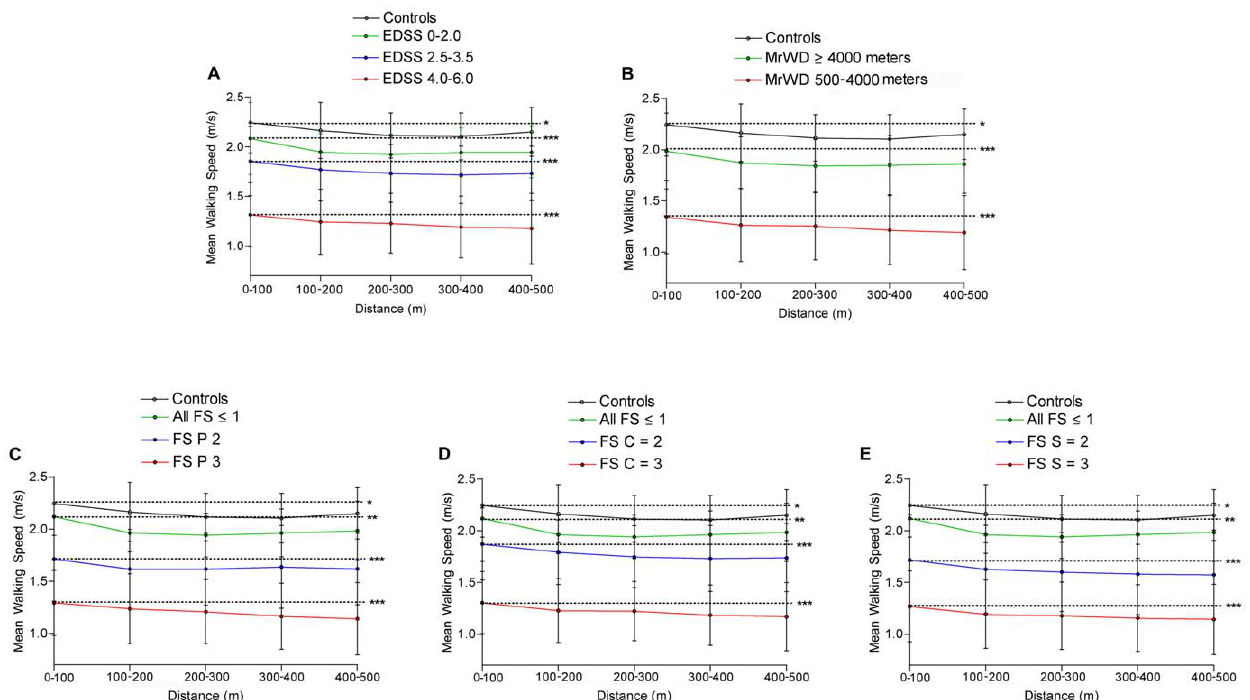
Figure 2. MWS over five successive 100 m interval laps along the T500MW. Subgroup analysis are presented in healthy volunteers and in different subgroups of the pMS population, stratified according to their EDSS (A), their maximum reported walking distance (MrWD) (B), and their pyramidal (C), cerebellar (D) and sensitive (E) functional scores (FS). The dashed lines represent the comparison between the ‘‘baseline’’ MWS of the first 100 m (T0–100MW) and the ‘‘final’’ MWS of the last 100 m (T400–500MW) for all subgroups. t-test values were *p , 0.05, **p , 0.01, ***p , 0.0001.